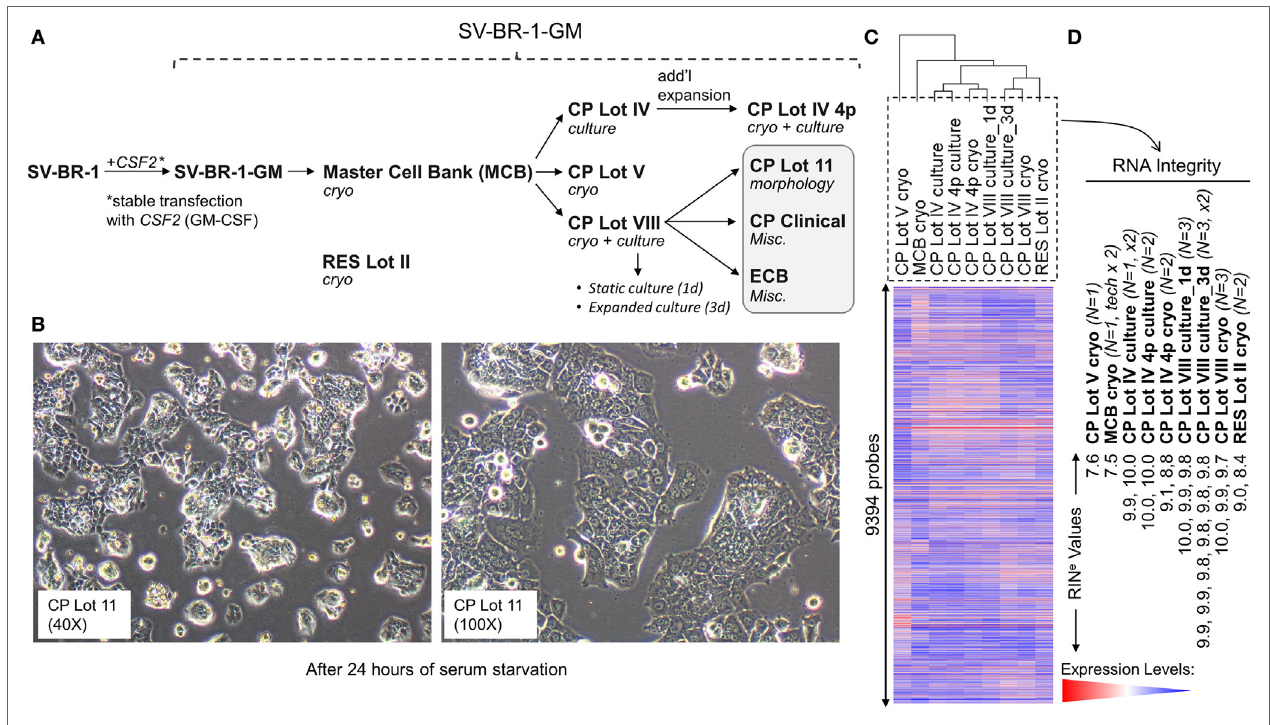
FigUre 1 | Development of SV-BR-1-GM. (a) The SV-BR-1-GM cell line was derived from SV-BR-1 breast cancer cells following stable transfection with CSF2 [encoding human granulocyte–macrophage colony-stimulating factor (GM-CSF)]. The SV-BR-1 cell line itself was established from a chest wall lesion of a metastatic breast cancer patient (16, 17). The depicted developmental stages of SV-BR-1-GM represent samples used for this study rather than provide a comprehensive overview of all lots generated thus far. From an original master cell bank (MCB), several “clinical product” (CP) lots for actual or potential clinical use were established. “RES Lot II” refers to a research sample type and “ECB” to an engineering cell bank. RNA for gene expression analysis was extracted from cells taken directly from cryogenic vials (“cryo”) or following a culturing step (“culture”). “CP Lot VIII” was studied both as a presumptive static culture (“1d”) and as an expanded culture (“3d”), whereby for the former, samples were harvested on the first day ( t = 0), and for the latter, on the third day ( t = 2, i.e., 2 days later) of a time-course assessing GM-CSF secretion (outlined in Figure S5 in Supplementary Presentation S1 in Supplementary Material). Although no culture expansion took place from seeding to t = 0 (“static culture”), cell numbers of cultures harvested at t = 2 were 1.7–3.2 times the seeding cell numbers (“expanded culture”). (B) Culture morphology of SV-BR-1-GM, as exemplified by 40 × and 100 × original magnifications of a culture derived from the SV-BR-1-GM Lot 11 bank following 24 h of serum starvation. Of note, SV-BR-1-GM cells may grow in monolayers but can also grow as minimally adherent, sphere-like, structures, especially when seeded at very low densities. (c,D) Quality control (QC). (c) Hierarchical clustering of SV-BR-1-GM samples based on their microarray gene expression profiles. Normalized gene expression levels of samples belonging to the same sample type were averaged (arithmetic mean) prior to clustering. (D) Only samples with a RIN e value of at least 7.5 were used for this study. Note that the CP Lot V cryo sample clustered separately and did not pass the minimal variability QC metric (see Materials and Methods) and was thus excluded from additional